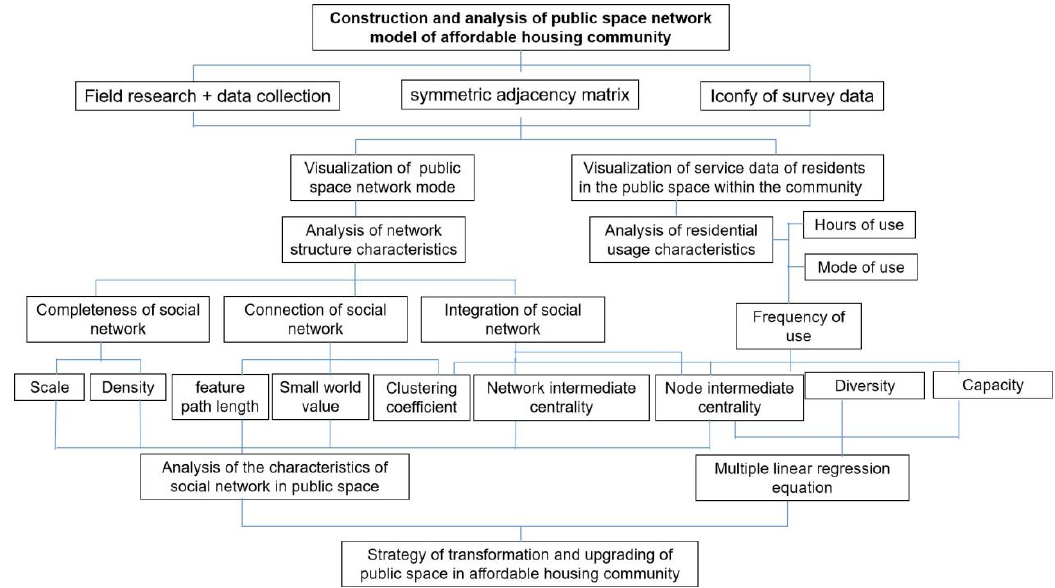
Figure 1. The technical route of space layout optimization in affordable housing based on social network analysis.